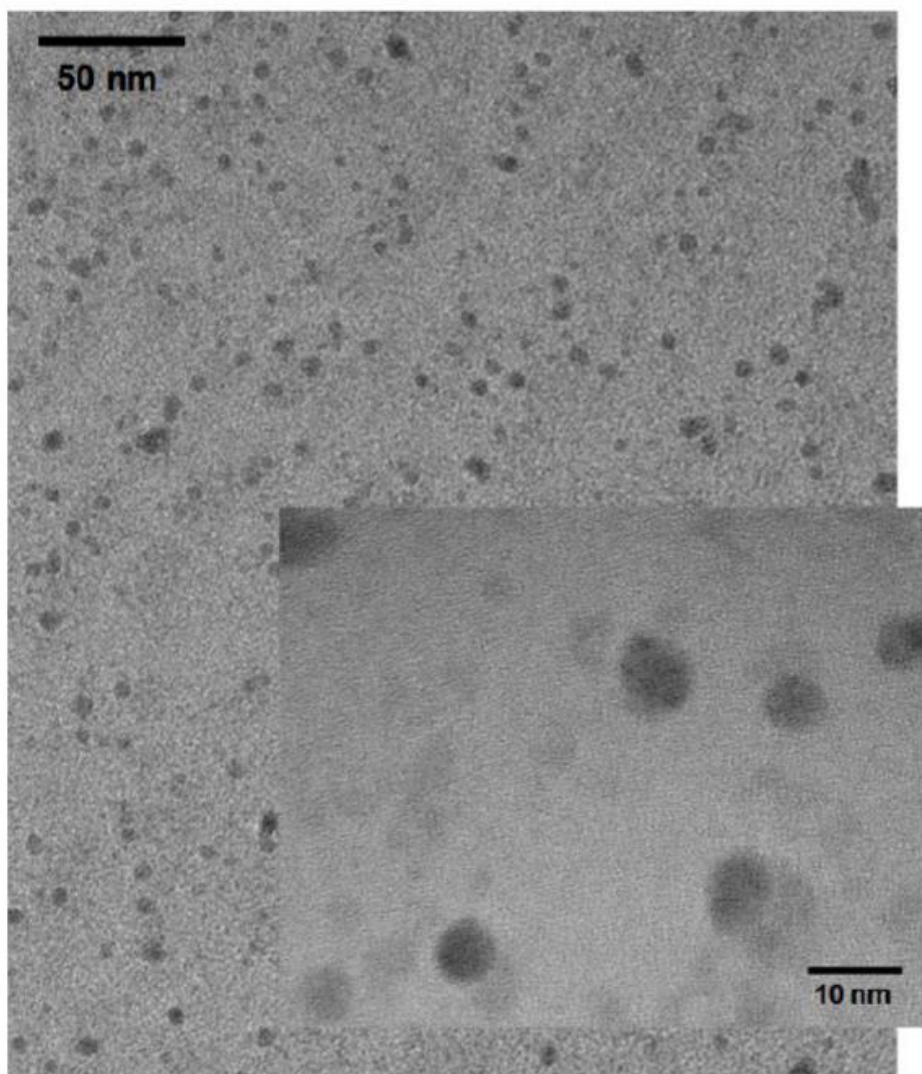
Figure 4. TEM images of NEC-CDots on silicon oxide coated copper grid, with those imaged at a higher resolution in the inset.